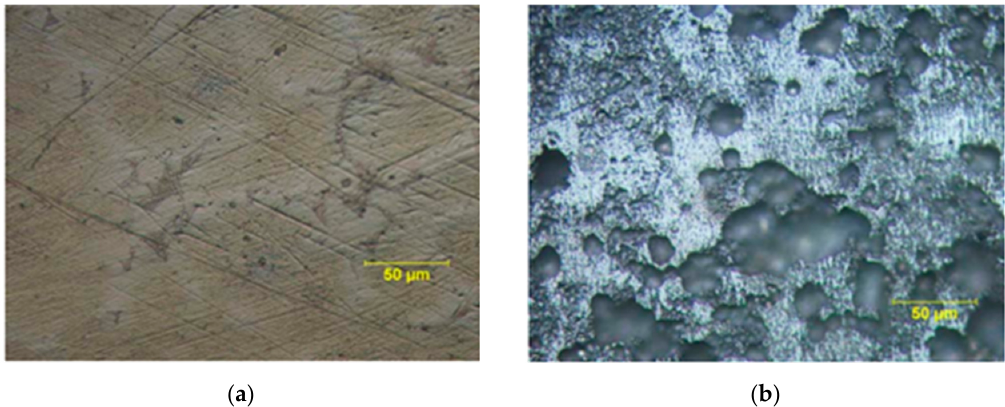
Figure 5. Optical microscopy images of as-cast WE43 ( a ) before the 1st day and ( b ) after the 7th day.